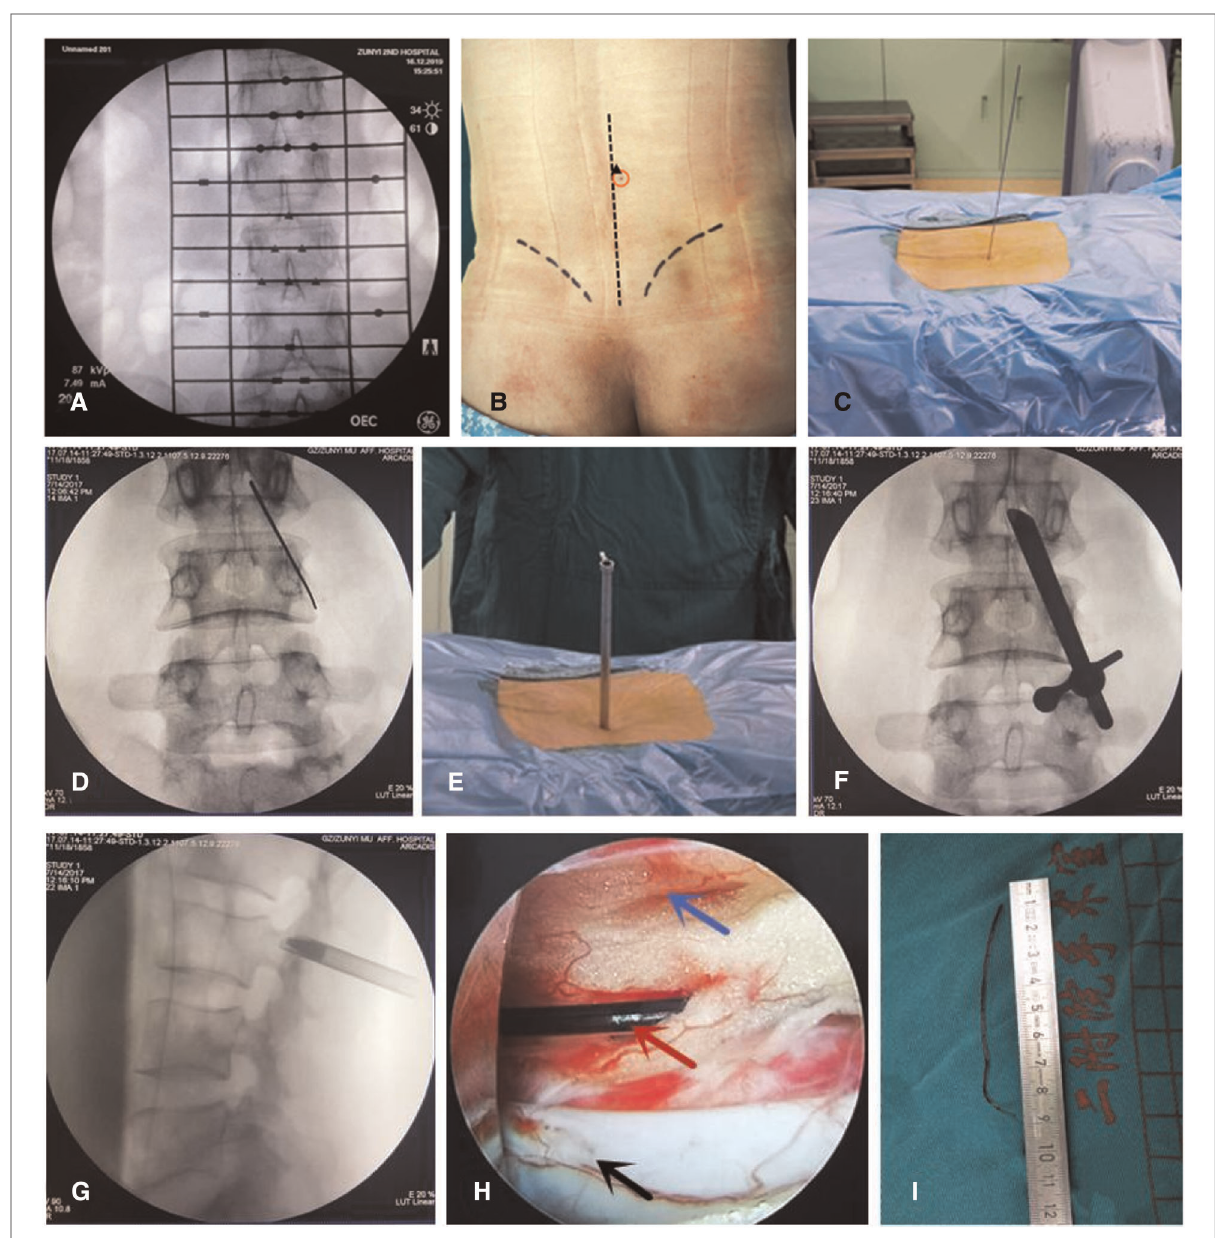
FIGURE 1 Typical case: Female, 26 years old, cesarean section, lumbar 2-3 epidural space cephalic catheter rupture and residual epidural catheter. ( A,B ) x-ray was used to locate the puncture gap and mark the puncture point; ( C ) a puncture guide needle was inserted at the marked point; ( D ) x-ray fl uoroscopy was used to determine the correct position of the guide needle; ( E ) a working sleeve was placed; ( F,G ) x-ray fl uoroscopy was performed to ensure that the working sleeve was positioned correctly and that the depth was appropriate; ( H ) The residual epidural catheter was clearly visible under the endoscopic vie; ( I ) Remove the remaining epidural catheter